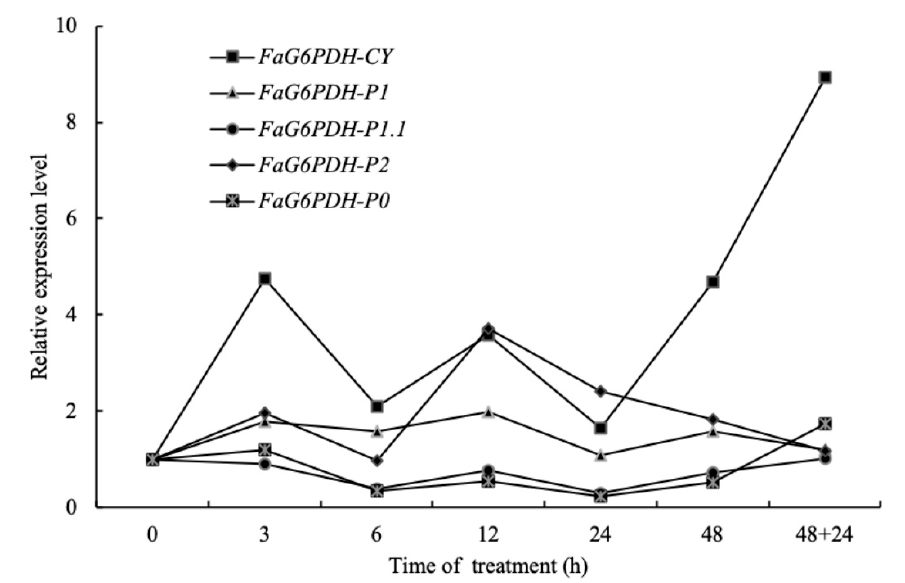
Figure 4. Relative expression level of FaG6PDH genes under cold stress. Potted strawberry plantlets were directly subjected to cold stress at 0 ◦ C. Leaves were sampled at 0, 3, 6, 12, 24 and 48 h after treatment. Subsequently, plants were taken out to de-acclimate at room temperature for 24 h. All above samples were used to detect the expression of FaG6PDH genes by qRT-PCR.